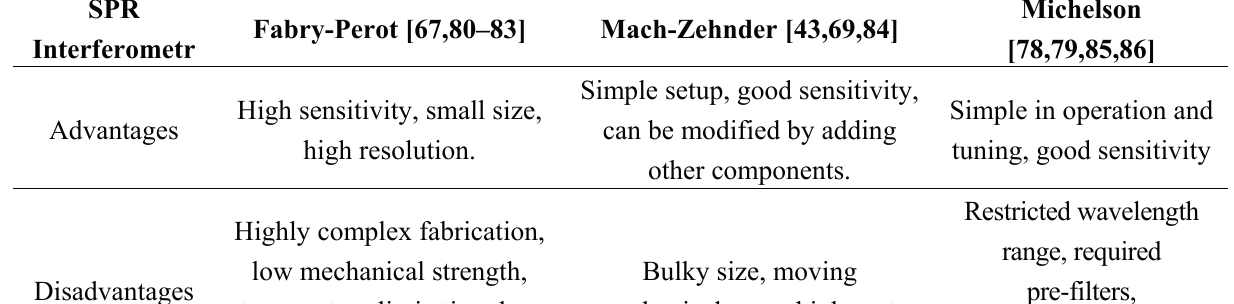
Table 2. Tradeoffs in the Fabry-Perot, Mach-Zehnder and Michelson interferometers.